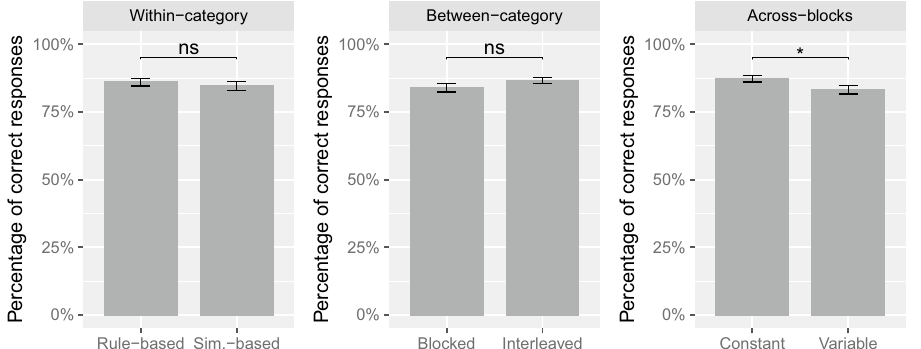
Figure 6. Percentage of correct responses for the learning stimuli presented during transfer, as a function of the types of order (taken separately). Percentage of correct responses was first computed for each participant before being averaged across participants. Error bars show ± 1 SE . Statistical significance of the two-sided Wilcoxon- Mann-Whitney test is shown on the